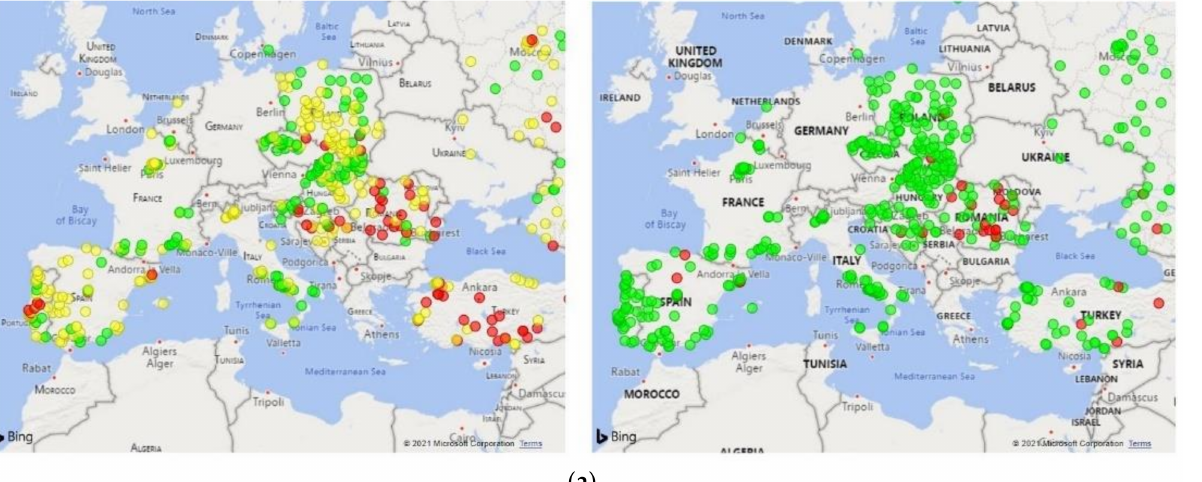
2020, and 3 January 2020 (Figure 5). The graphical representation visually highlights clinic